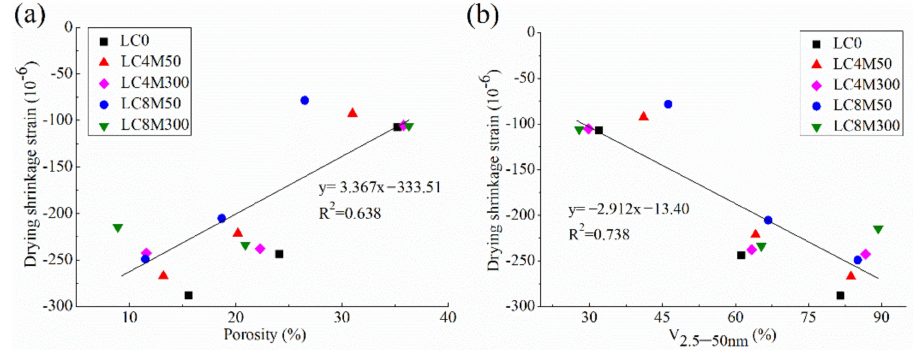
Figure 7. Correlation of drying shrinkage with ( a ) porosity and ( b ) V 2.5–50 nm .